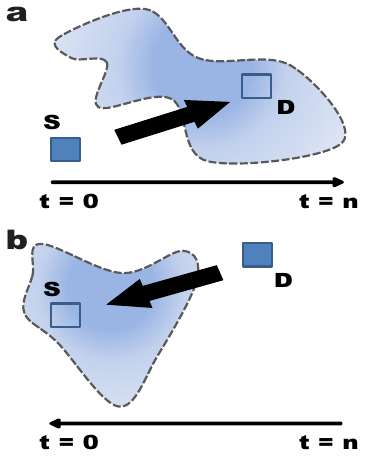
Figure 4. Diagram showing the principle of reciprocity of atmospheric transport using an adjoint model. (a) shows the dispersion of a mass m of tracerin the forward model, released from box “ S ” at time t =0 after n model timesteps. Concentration is indicated by colour intensity. (b) shows the equivalent adjoint transport for a mass m of tracer, released from grid box “ D ” at time n , integrated backwards to time 0 . The mass of tracer in box “ D ” in (a) at time n and in box “ S ” in (b) at time 0 is identical.